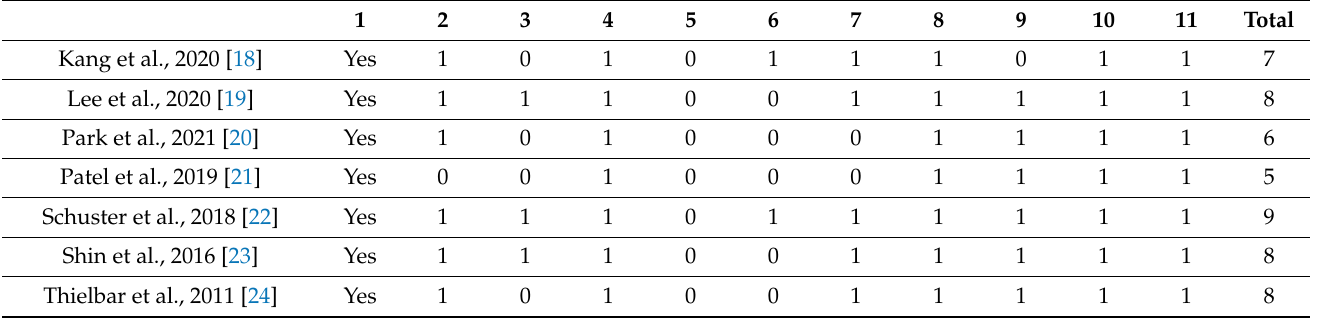
Table A2. Methodological quality assessment of the included studies with PEDro scale.